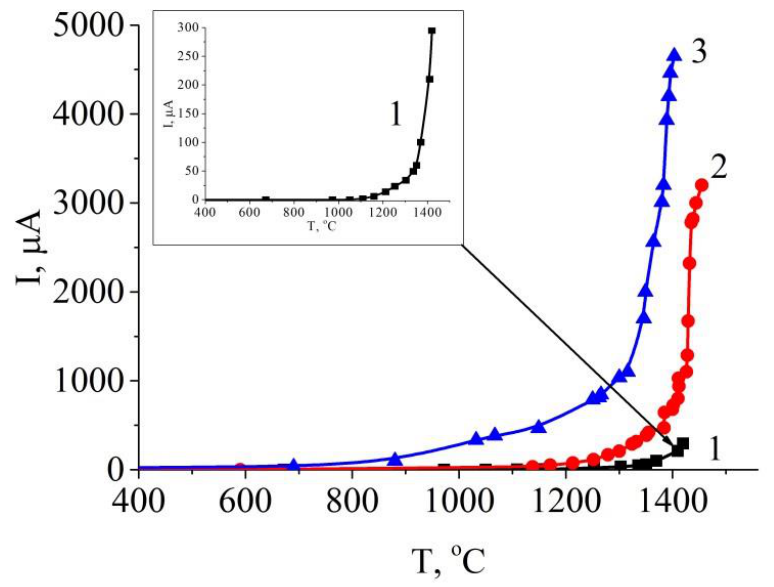
Figure 6. Temperature dependence of current through composites during electron-beam sintering: (1) composite 75A; (2) composite 50A; (3) composite 25A.